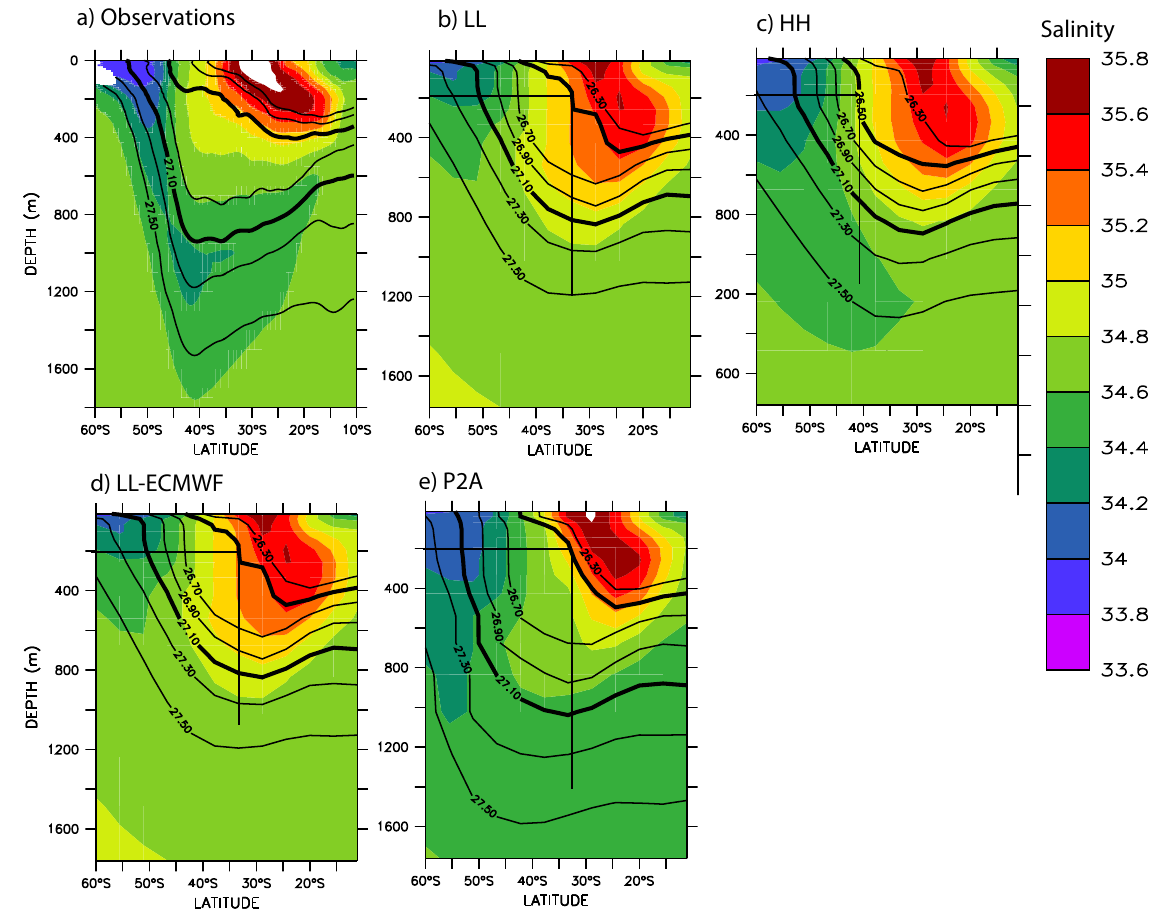
Fig. 5. Salinity (colors) and density (contours) along 100 ◦ E in (a) observations and (b–e) the 4 models, as labeled above each panel. The SAMW layer is visible as a pycnostad between the 26.5 and 27.1 isopycnals just north of the ACC, and the AAIW is characterized by a salinity minimum on the dense side of the SAMW. Observations taken from the CARS2006 database (Ridgway et al., 2002). Vertical lines show the time-mean boundary used to separate the SAMW tag region from the low-latitudes in the